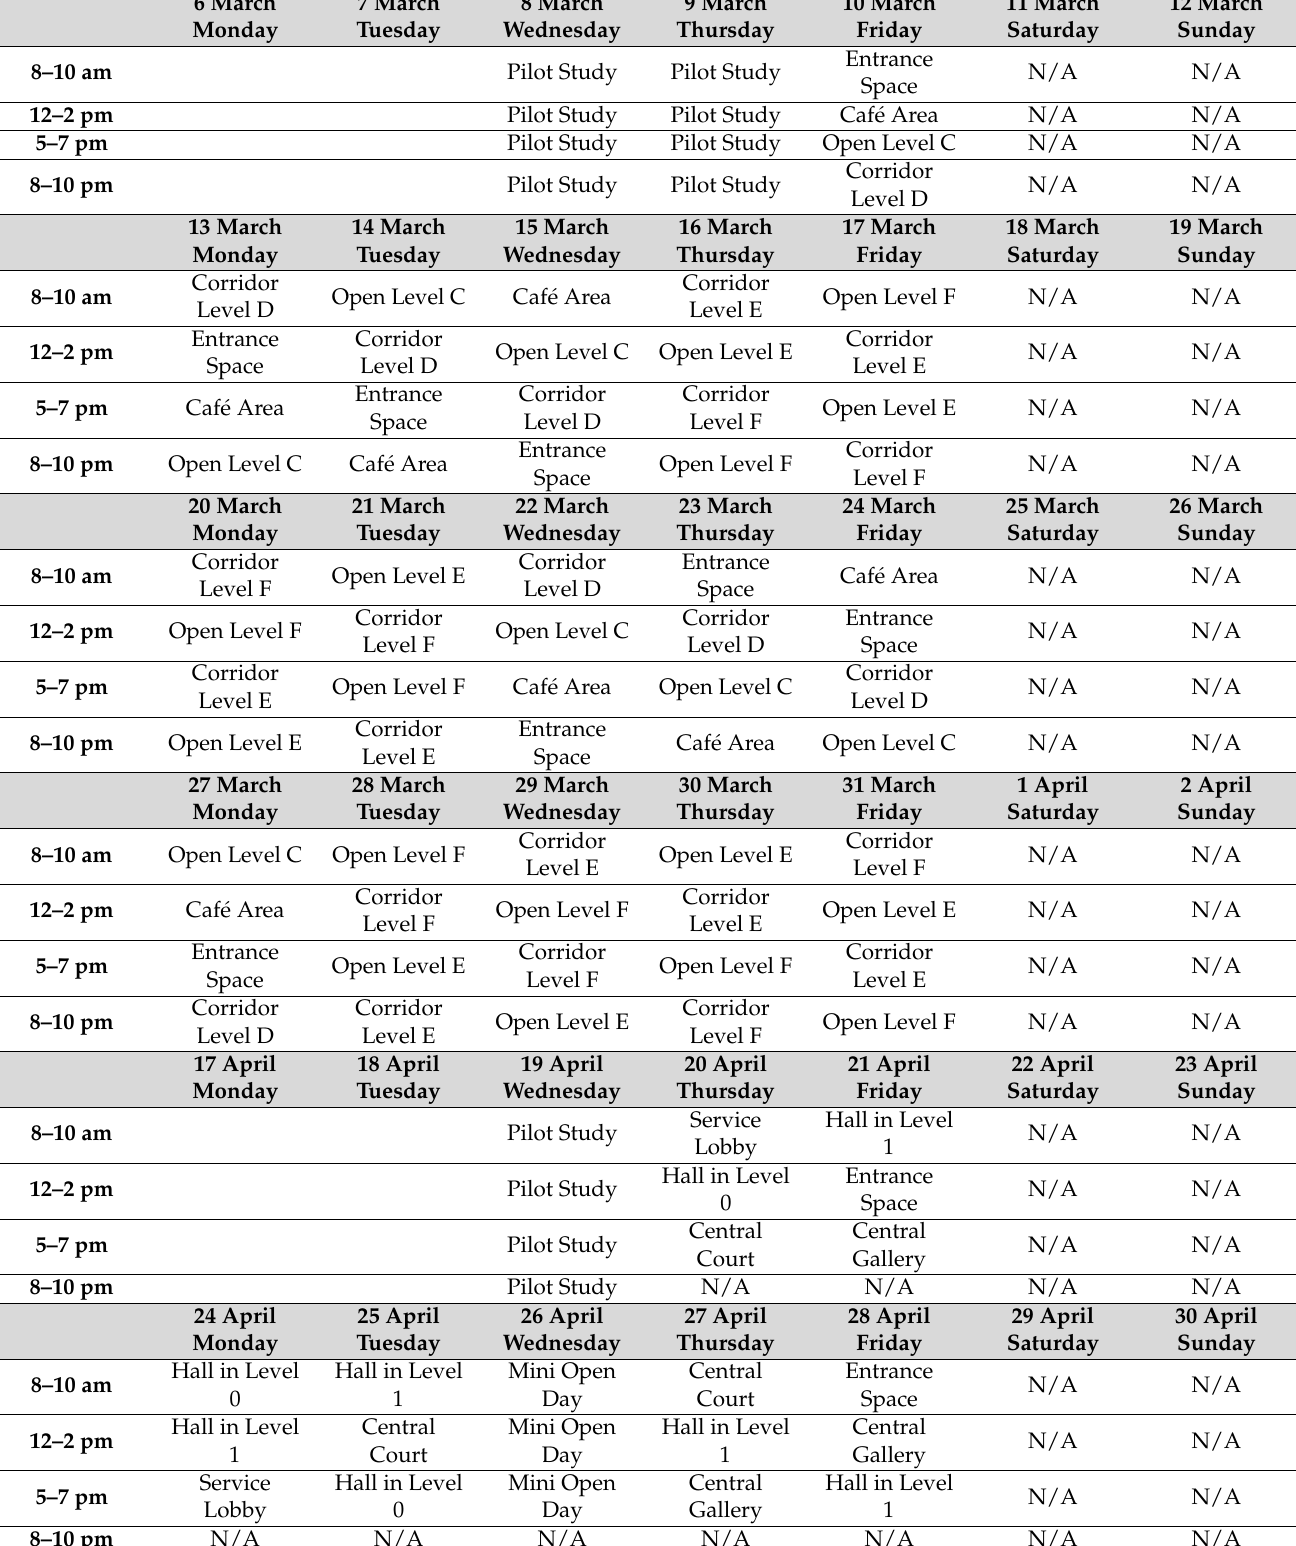
Table 2. Observation schedule of Diamond at University of Sheffield (8–31 March) and Newton at Nottingham Trent University (19 April–10